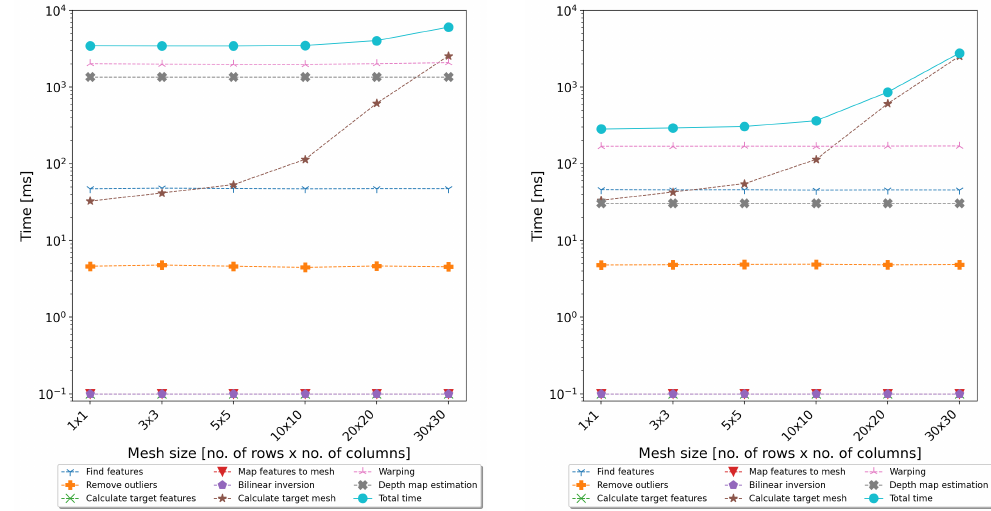
Figure 9. Results of the performance evaluation using the desktop computer—execution time of individual steps of the algorithms on a CPU ( left ) and GPU ( right